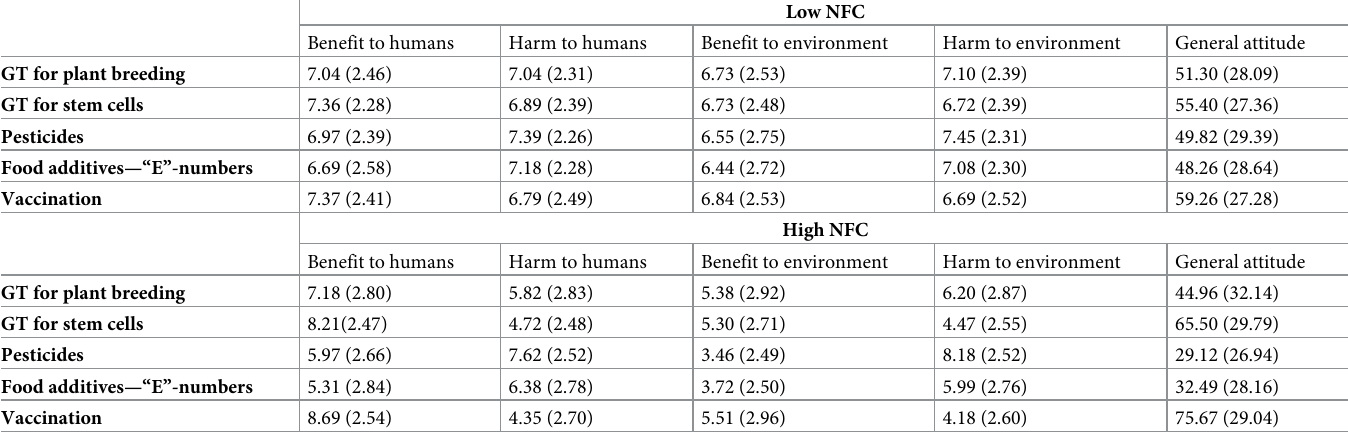
Table 1. Mean benefit and harm judgements for food and medical application of technologies by low Need for Cognition (NFC) (N = 500; upper) and high Need for Cognition (NFC) (N = 635; lower).